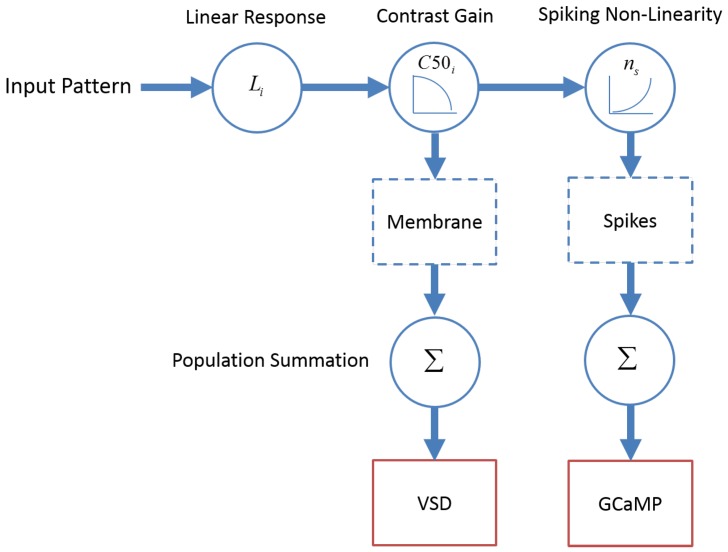
A computational framework relating GCaMP and VSD signals to single neuron membrane potential and spiking activity.Membrane potential of V1 neurons reflect a dot product of the visual input with the linear receptive field followed by contrast gain control. The neural mechanism producing spikes from membrane potential is described by a power-law non-linearity. As a first approximation, GCaMP and VSD signals reflect spiking activity and membrane potential, respectively, pooled over a local population of neurons with heterogeneous tuning properties.